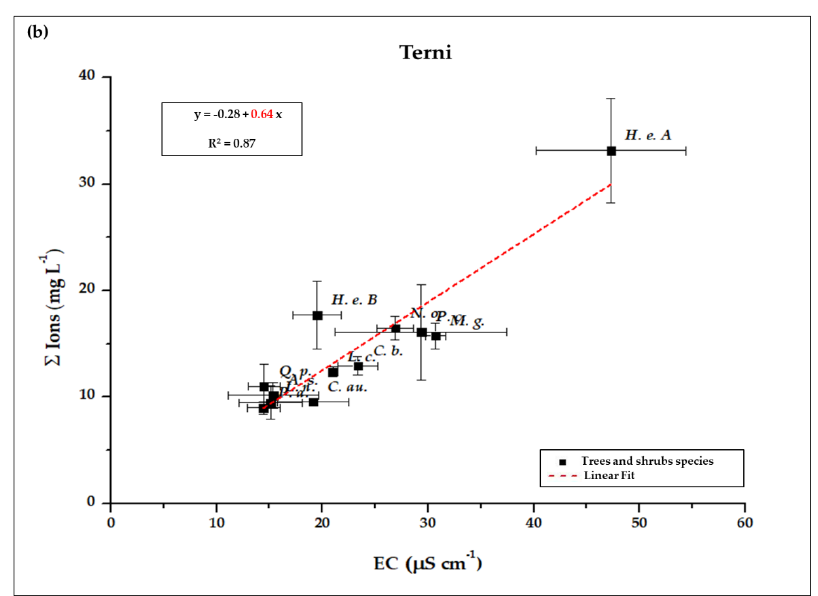
Figure 3. Relationship between ∑ Ions (mg L − 1 ) and electrical conductivity (EC)) ( µS cm − 1 ) of washing solutions from: ( a ) Q. ilex (L.) leaves sampled in seven sites within an urban forest in Naples; ( b ) leaves from selected tree and shrub species from an urban park in Terni. Values of ∑ Ions (mg L − 1 ) and EC (µS cm − 1 ) are obtained as averaged over two replicate branches. Standard deviations are shown. The linear regressions are obtained by considering only the samples characterized by ionic balanced washing solutions.